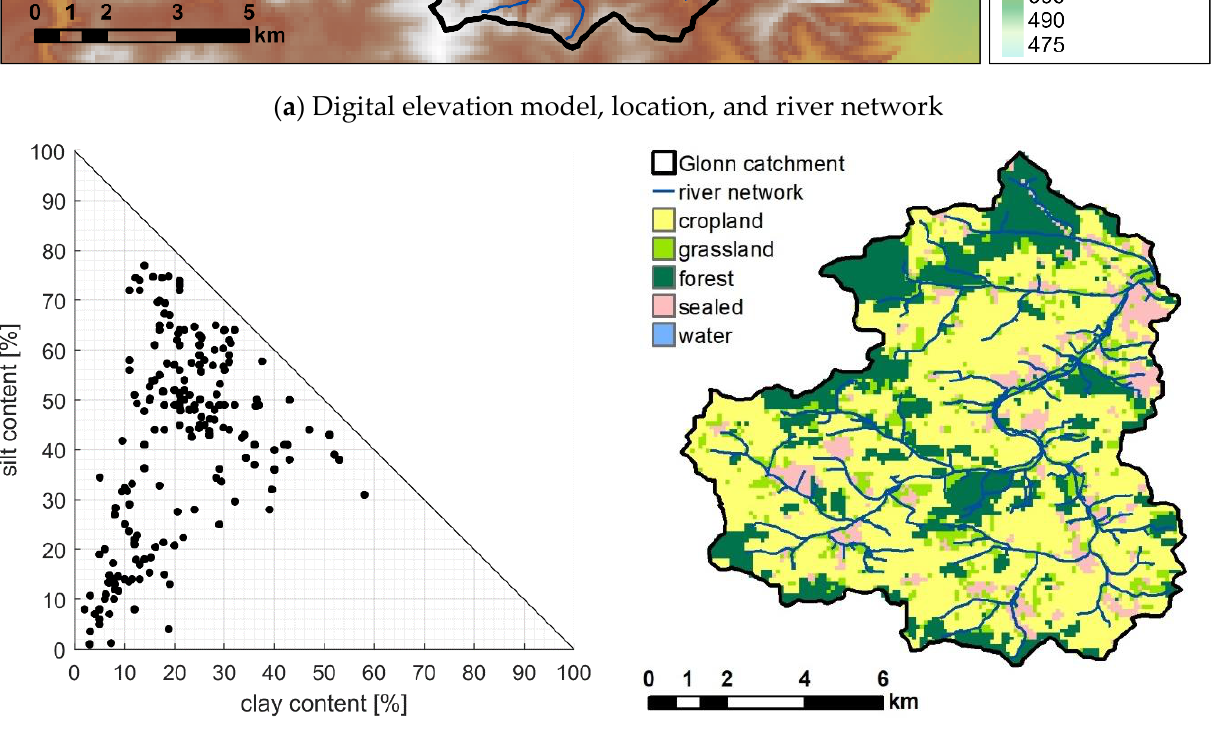
Figure 1. Topography ( a ), soil characteristics ( b ), and land use ( c ) of the Glonn catchment.